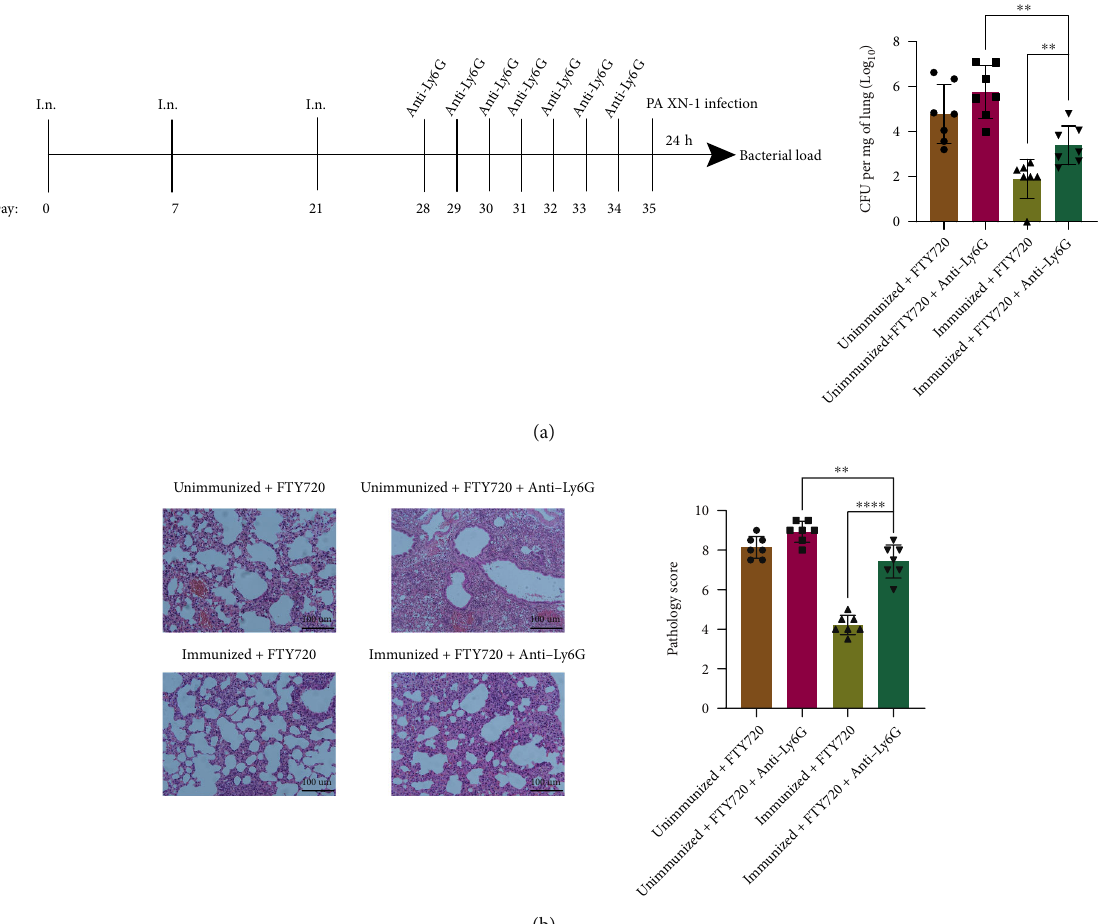
Figure 7: Depletion of neutrophils impairs clearance of Pseudomonas aeruginosa from the lung. (a) Experimental timeline. Lung CFU 24 hours after infection in FTY720 treatment mice with or without anti-Ly6G Ab and FTY720 treatment-immunized mice with or without anti-Ly6G Ab ( n = 7 ). (b) Representative H and E stains in FTY720 treatment mice with or without anti-Ly6G Ab and FTY720 treatment-immunized mice with or without anti-Ly6G Ab ( n = 7 ). Signi fi cant di ff erences were calculated by using Student ’ s t -test. ∗ P < 0 : 05 ; ∗∗ P < 0 : 01 ; ∗∗∗ P < 0 : 001 ; ∗∗∗∗ P < 0 : 0001